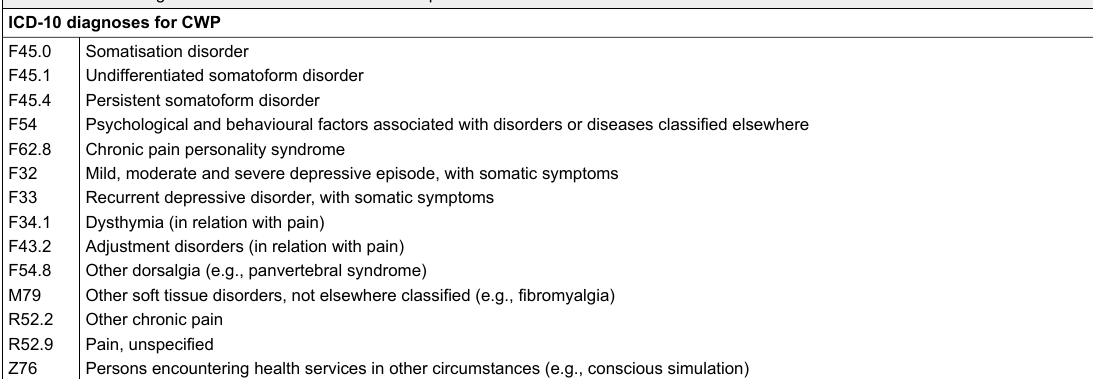
Table 2: ICD-10 diagnoses for CWP included in the sample. ICD-10 diagnoses for